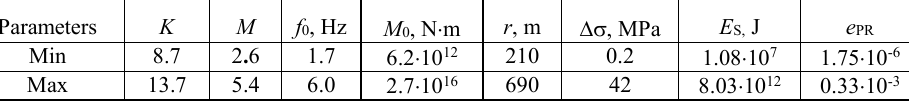
Table 2. Boundary values of dynamic parameters (182